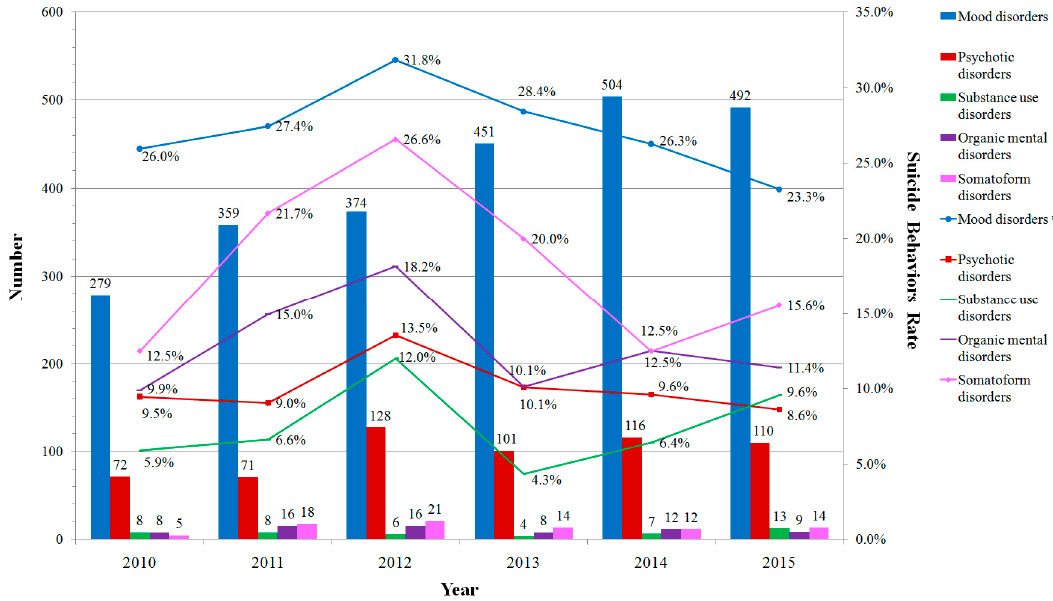
Figure 2. Numbers and suicidal behavior rates of inpatients with each category of mental disorders in Beijing Anding Hospital, 2010–2015 (* linear-by-linear association: χ 2 = 8.4, p =